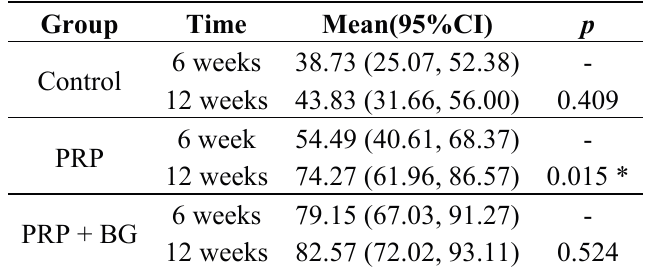
Table 2. T -test between different times in 3 groups separately.